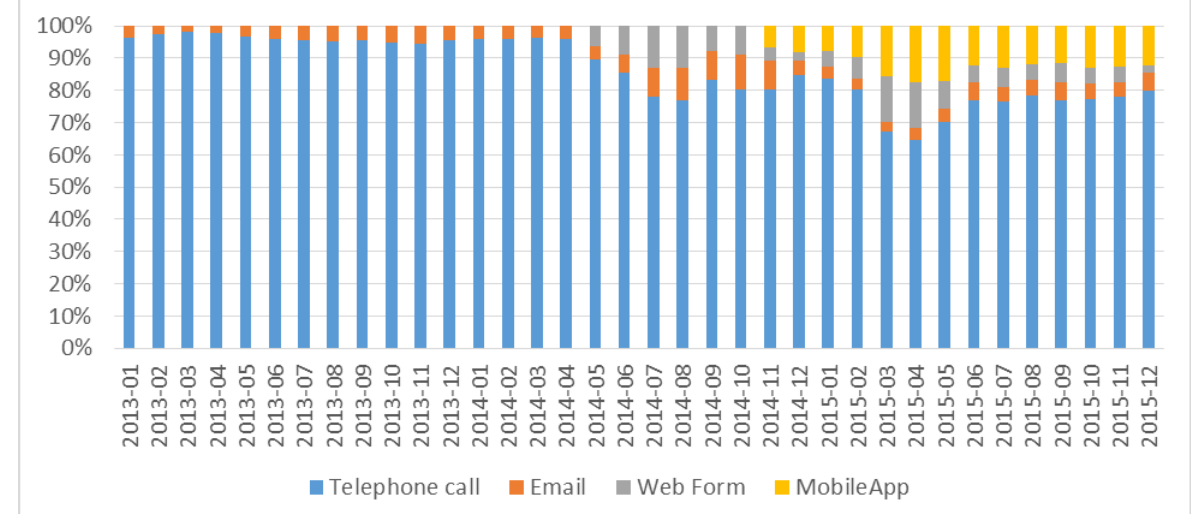
Figure 2. Percentage of requests from channels by month (From January 2013 to December